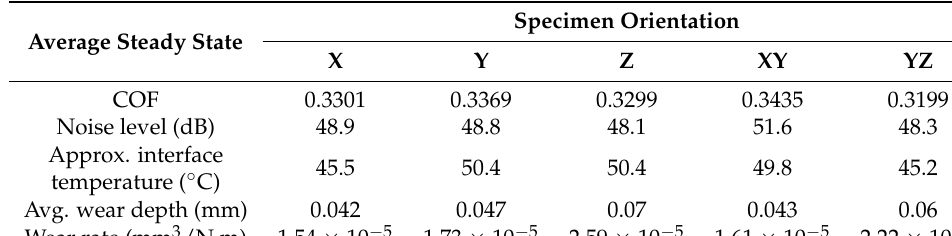
Figure 11. SEM of the tribo-surface for the X-oriented specimen (50 N, 0.25 m/s, and 45 min) at 350× ( a ) and 1000× ( b ) magnification.